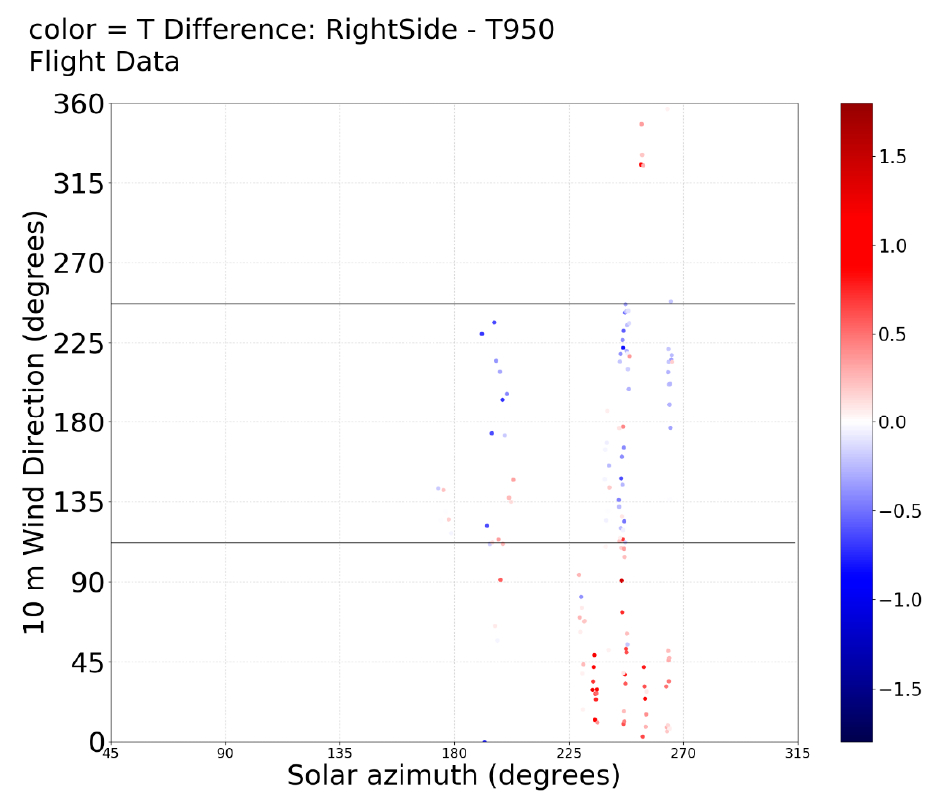
Figure 7. Temperature differences (°C, color) between the iMET- XQ in the RightSide location on the UAV (iMET17) and the 9.5 m tower thermistor as a function of the 10 m wind direction (y axis) and the solar azimuth angle (x axis). The black horizontal lines are drawn at the wind directions of 112° and 247°.